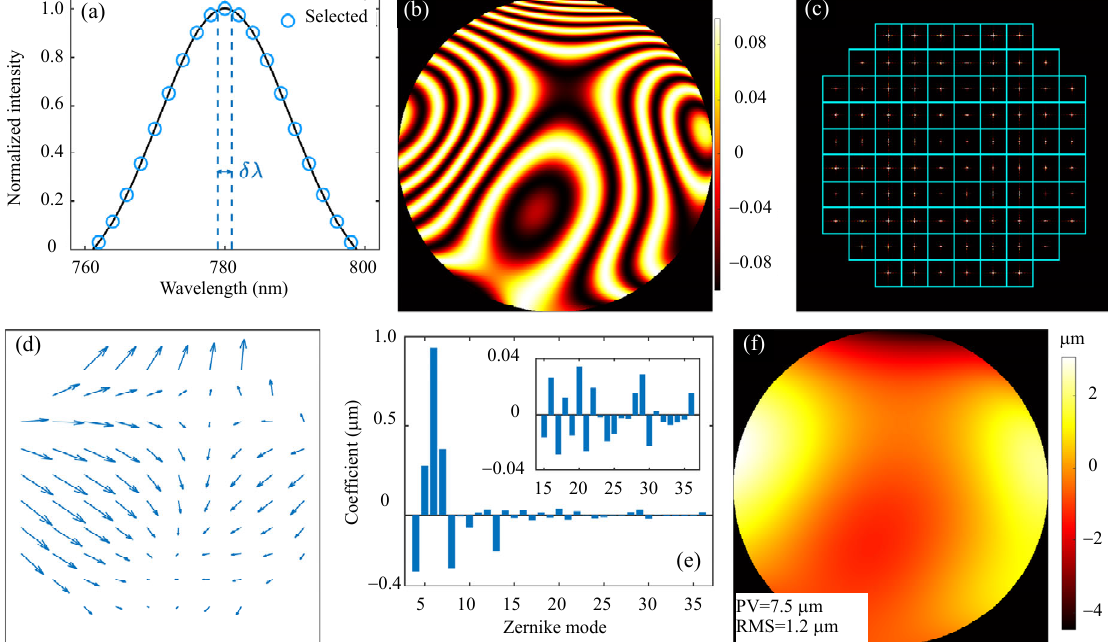
Fig. 2 Results of some main steps of MWCW method: (a) spectral distribution S (  ) and selected  , (b) real part of entire complex electric field, (c) diffracted spots corresponding to  0, (d) weighted centroid displacements, (e) obtained Zernike coefficients, and (f) reconstructed